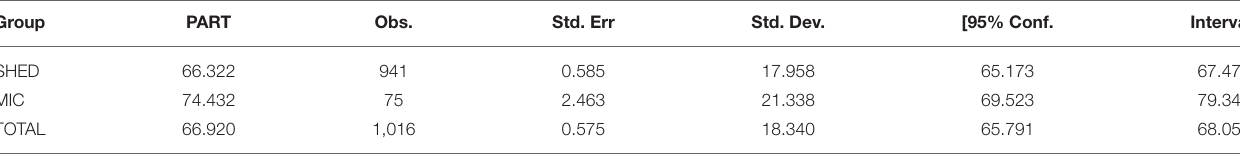
TABLE 3 | Performance of departmental agencies and independent commissions. Group PART Obs. Std. Err Std. Dev. [95% Conf.